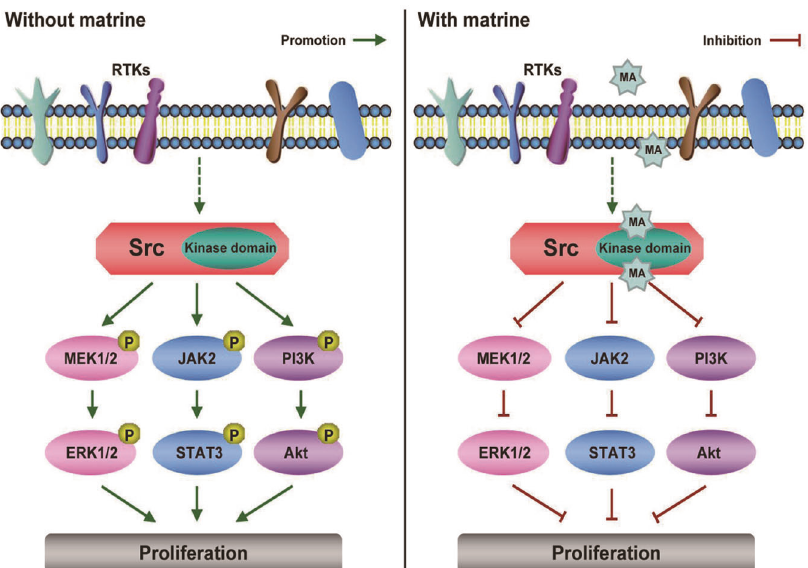
Fig. 7 Schematic diagram of matrine inhibiting the proliferation of cancer cells. Src promotes the proliferation of cancer cells via the MAPK/ERK, JAK2/STAT3, and PI3K/Akt phosphorylation signaling pathways. Matrine may target Src protein and inhibit its kinase activity to inhibit the proliferation of cancer cells by blocking the related phosphorylation signaling